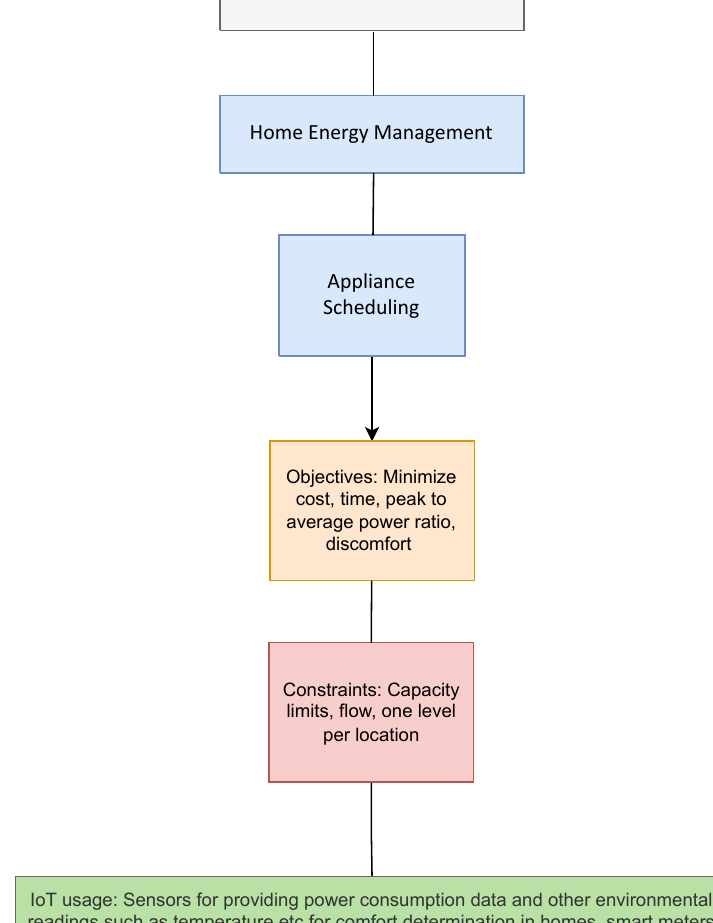
Figure 5. Optimization applications in Smart